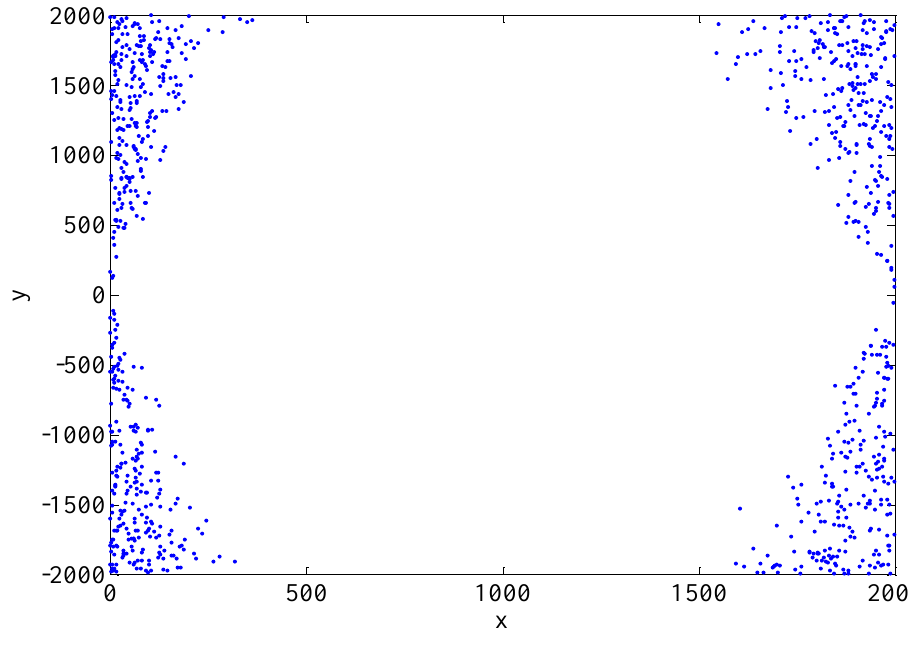
Figure 14. Distribution of the divergence points for